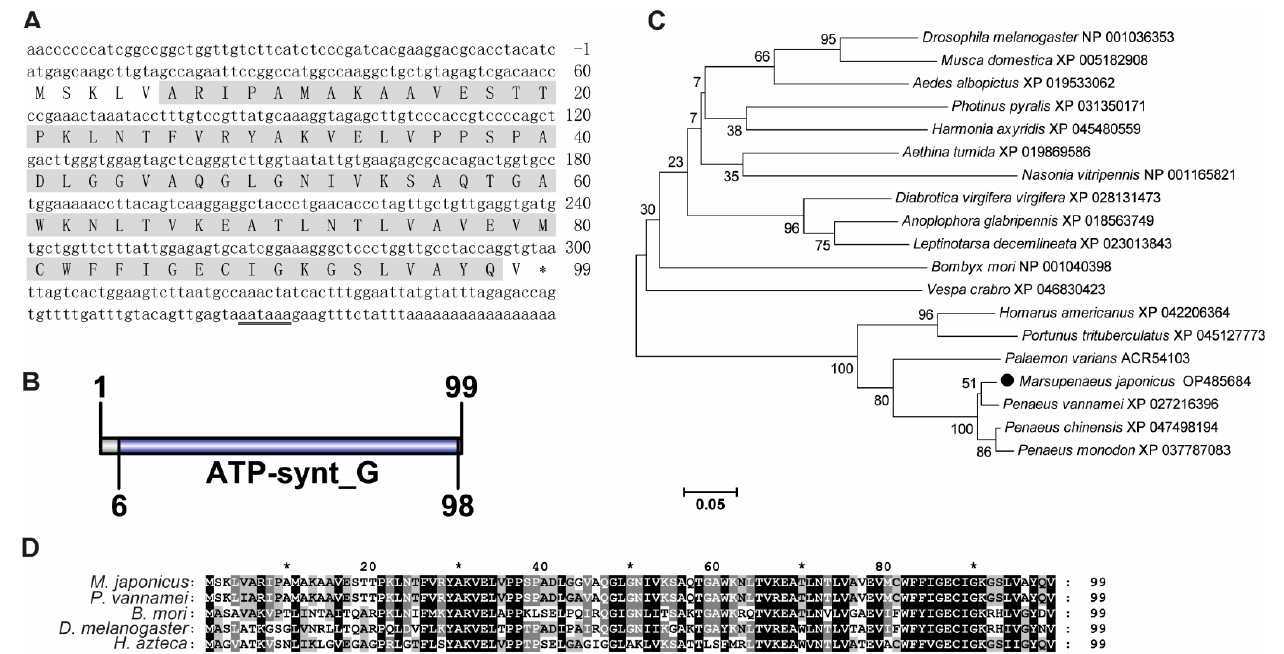
Figure 2. Sequence analysis of Mj ATP5L. ( A ) The nucleotide and deduced amino acid sequence of Mj ATP5L. The letters with a grey background represent the ATP synthase subunit g domain. The double-underlined nucleotides show the polyadenylation signal region. ( B ) The domain schematics of Mj ATP5L. Mj ATP5L contained an ATP synthase G domain with 93 amino acids. ( C ) Phylogenetic tree analysis of ATP5Ls from Aedes albopictus , Aethina tumida , Anoplophora glabripennis , Bombyx mori , Diabrotica virgifera virgifera , Drosophila melanogaster , Harmonia axyridis , Homarus americanus , Leptinotarsa Vespa crabro. ATP5L from M. japonicus is labeled by a black solid circle. All of the amino acid sequences were obtained from GenBank. ( D ) Multiple sequence alignment of ATP5L from M. japonicus , P. vannamei, B. mori, D. melanogaster , and Hyalella azteca . The conserved sites are labeled by white letters with a black